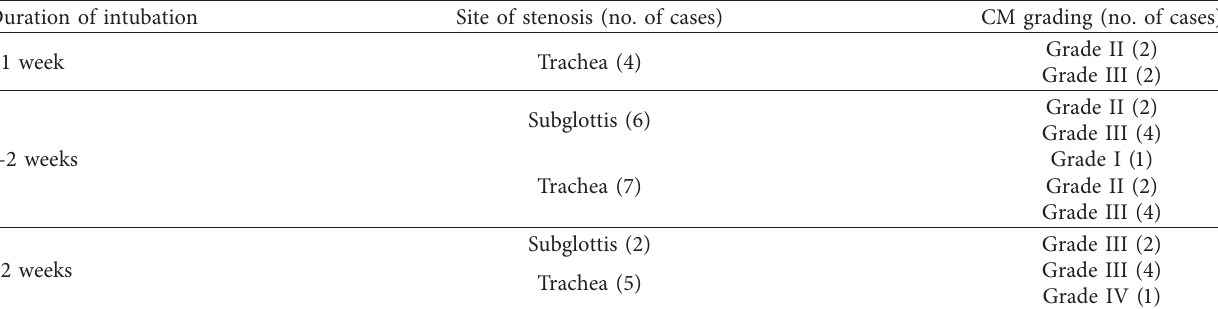
Table 4: Duration of intubation with site and grade of stenosis.